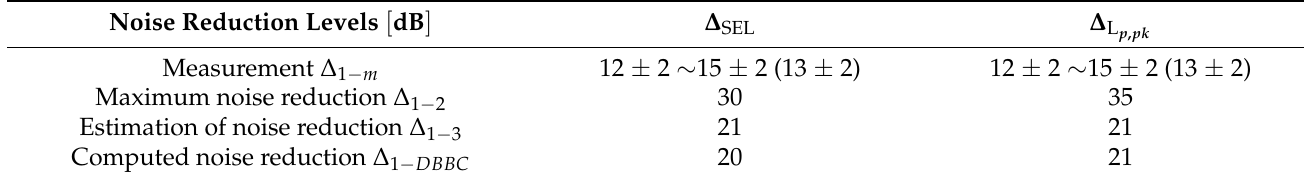
Table 5. The summary of the noise prognosis for the offshore pile